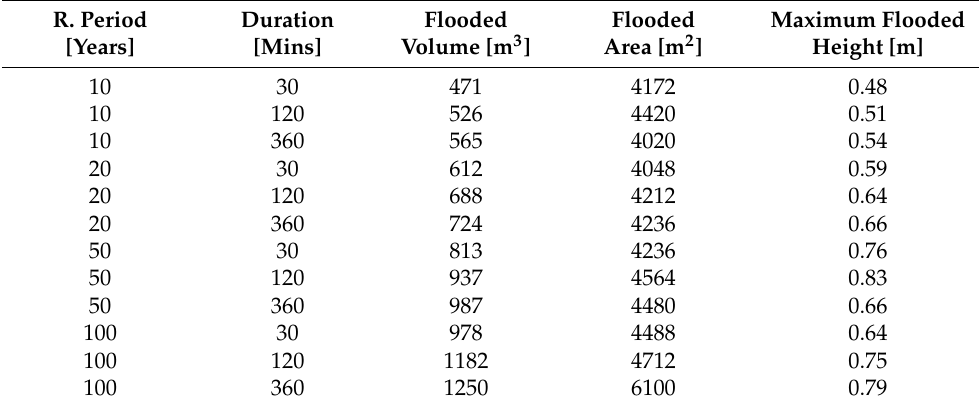
Table 6. Flooded volume, area, and height for the reference